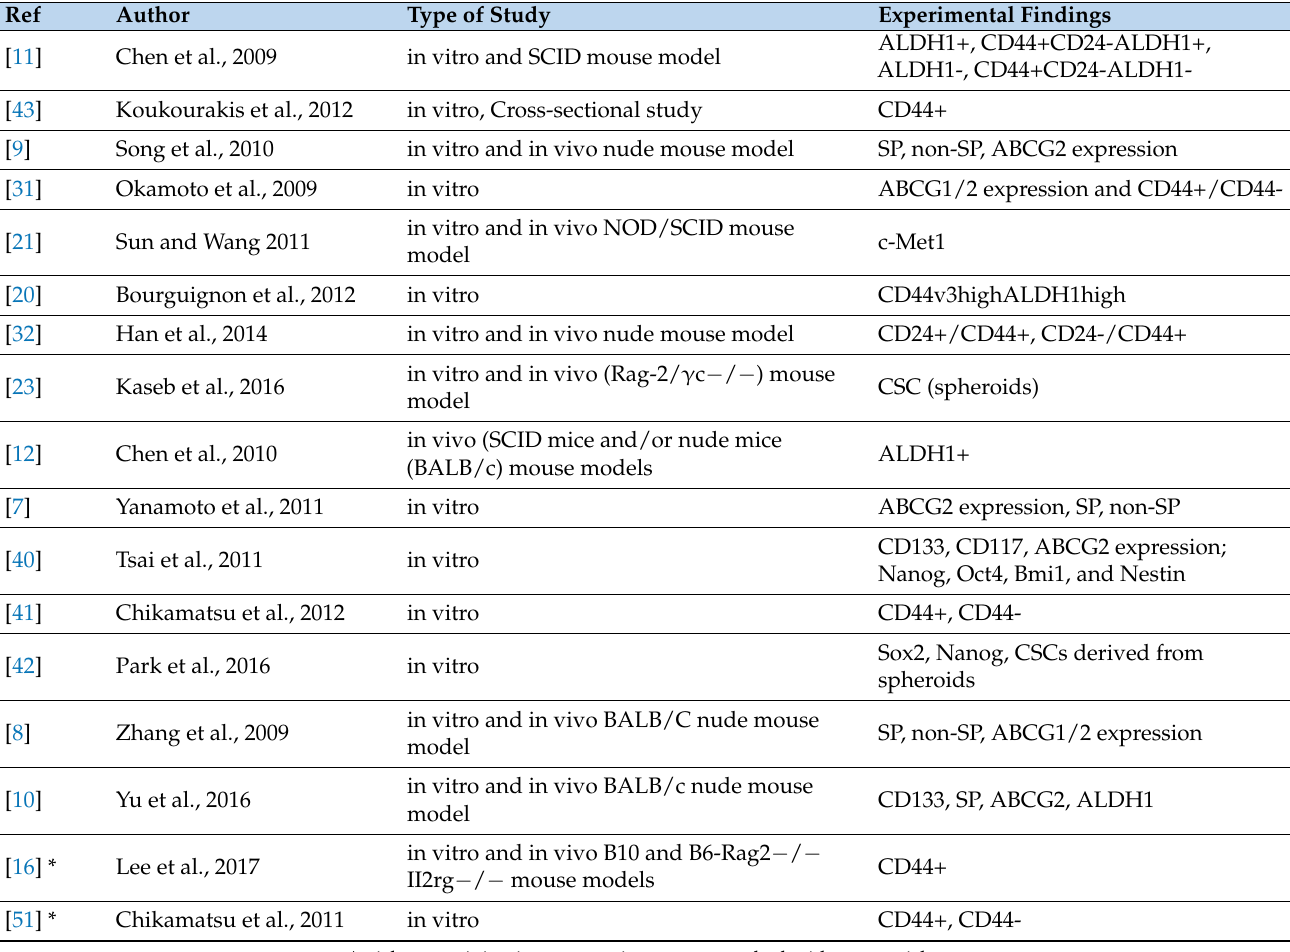
Table 3. Enhanced radio-chemo and immune resistance of Head and Neck Cancer Stem Cells. Experimental findings supporting the enhance radio-chemo resistance and upregulation of drug resistant and anti-apoptotic genes, as well as genes involved in immune regulation and in head and neck cancer stem